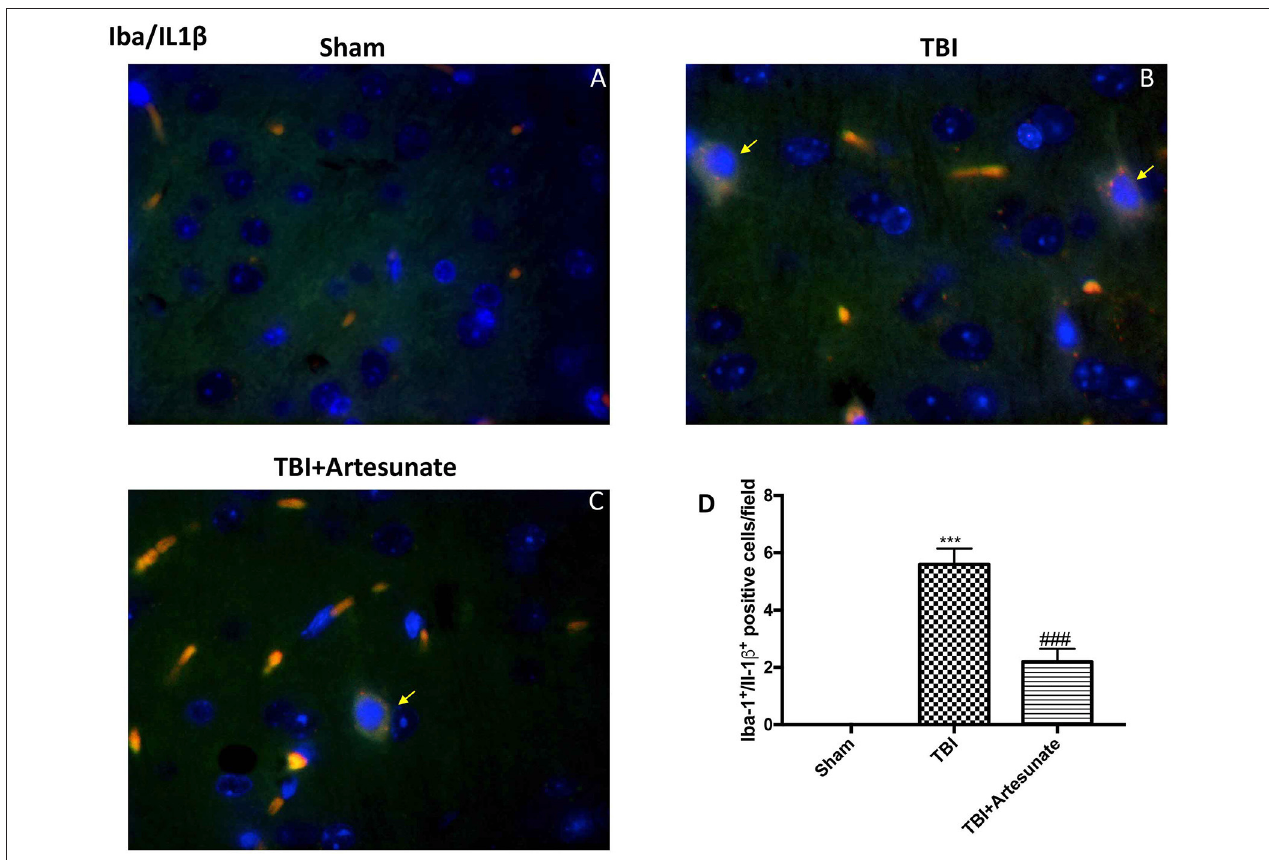
FIGURE 7 | Protective effect of artesunate treatment on microglial cell activation and cytokine production. (A) Showed no immunoreactivity for Iba-1 + /IL-1 β + in sham group. (B) Showed a significant increase in IBA-1 + /IL-1 β + co-localization. (C) Treatment with artesunate significantly reduced the TBI-induced expression of IBA-1 + /IL-1 β + . (D) Represent densitometric analysis. The yellow arrow indicates the co-localization between IBA-1 + /IL-1 β + . Data are expressed as Mean ± SEM from N = 10 Mice for each group, *** P < 0.001 vs. corresponding sham group. ### P < 0.001 vs. corresponding TBI. ( F -value = 238.8. df = 2. r 2 =